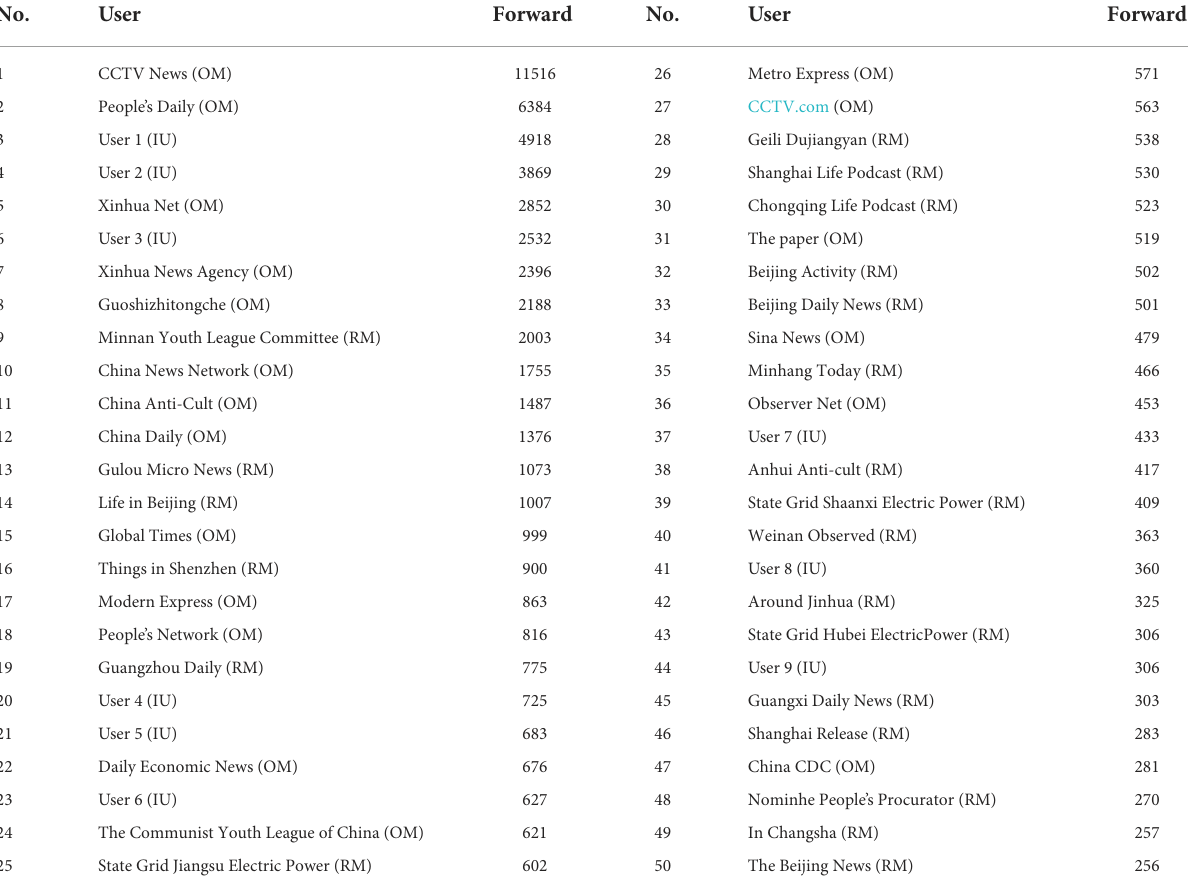
TABLE 3 Ranking of retweets of the Weibo account “COVID-19 vaccine topic posts”.